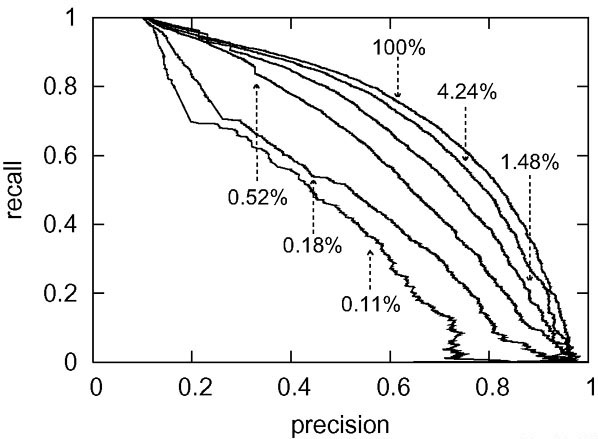
Impact of the Recursive Feature Elimination. Impact of removing 10% of the features with the lowest weight vector in each round. After 30 iterations, with only 4.28% of all features remaining, the f-measure has dropped only by 2%. The underlying evaluation method only considers the recognition of single tokens rather than whole phrases. The bottom line (65 iterations) shows the impact of the remaining 0.11% of all features. All values are evaluated without the post-expansion step (see text).